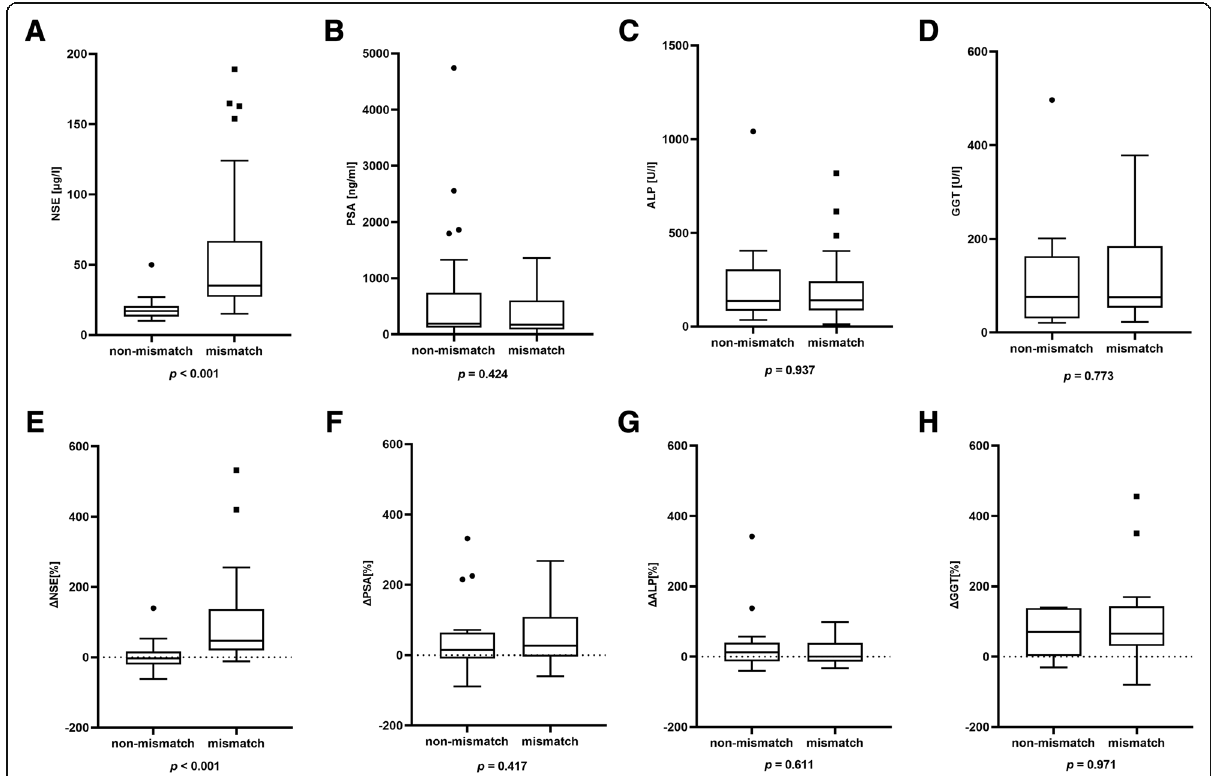
Fig. 3 Comparison of absolute serum values of NSE ( a ), PSA ( b ) and ALP ( c ) between all mismatch- and non-mismatch patients. Comparison of serum GGT ( d ) of patients having mismatch and non-mismatch liver metastases. Relative change of each parameter: Δ NSE ( e ), Δ PSA ( f ), Δ ALP ( g ), Δ GGT ( h ). Extreme outliers are not